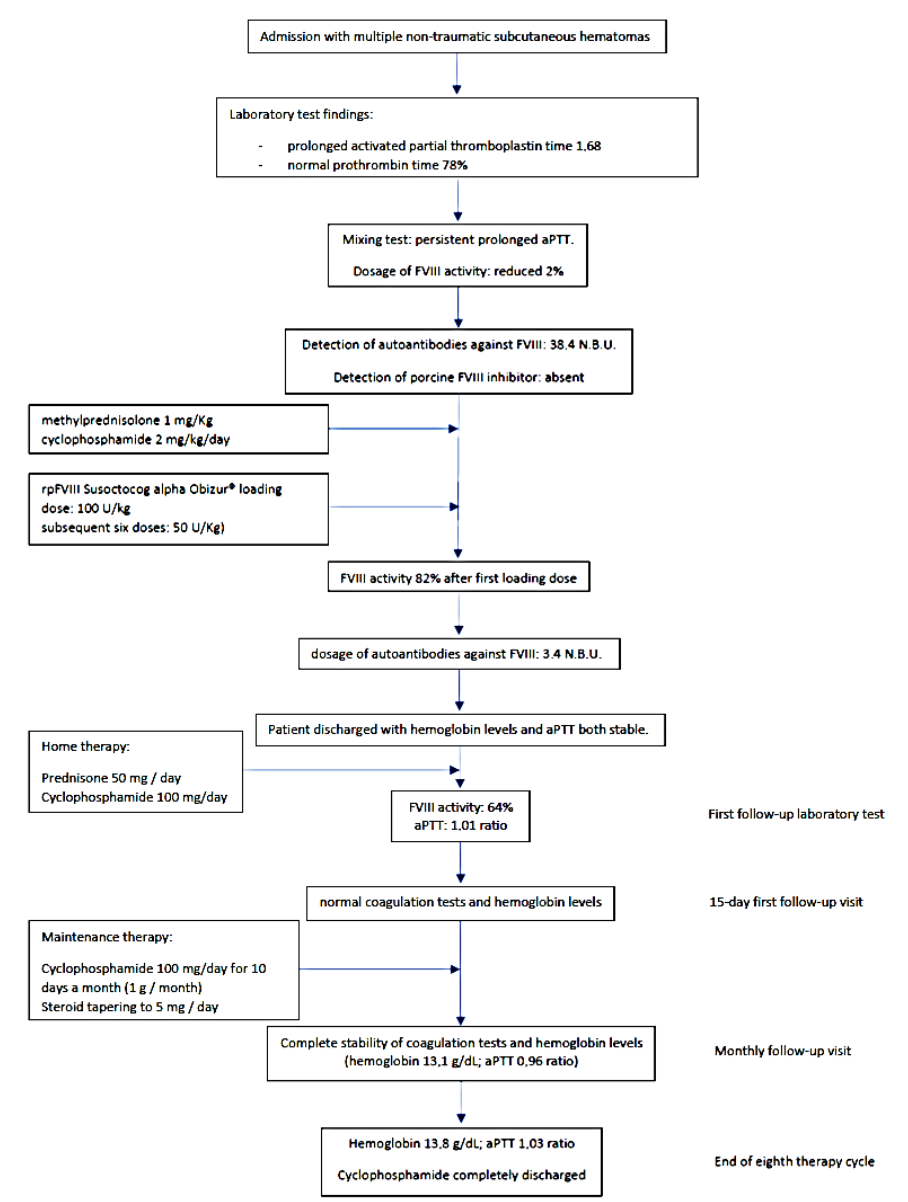
Figure 2. Flowchart of the case report’s clinical